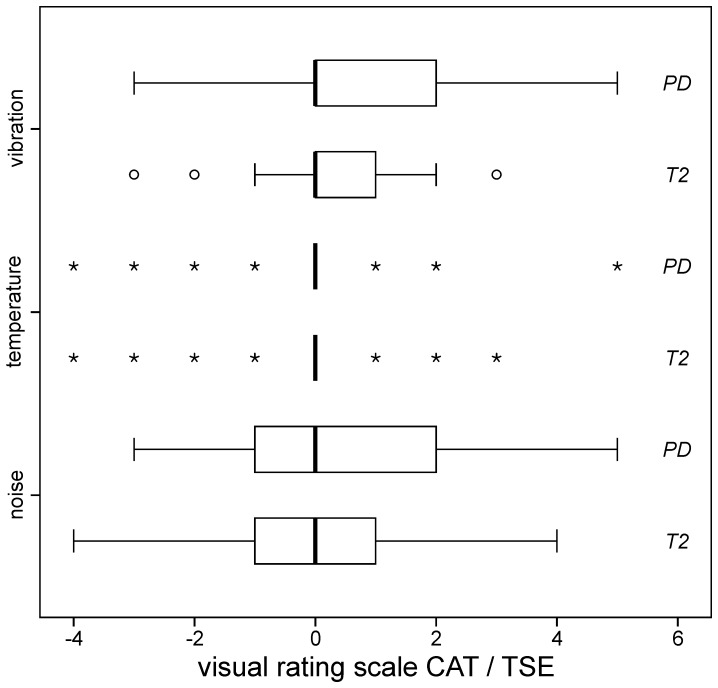
Subjective ratings.Rated sensations of RF-induced heating (top row), acoustic noise (middle row) and scanning vibrations (bottom row) for CAT compared to TSE (cf. Fig. 3). For the temperature ratings, only n  =  7 asterisks for PD and T2 scanning are displayed because just this few patients noticed temperature differences between CAT and TSE while the rest (n  =  33 out of 40 patients; 82.5 %) perceived zero difference. None of the ratings revealed significant differences between CAT and TSE, indicating that CAT is no more uncomfortable than TSE scanning. (box: upper and lower quartiles, thick black line: median, whiskers: most extreme values of the interquartile range, circle: outlier, asterisk: extreme value).